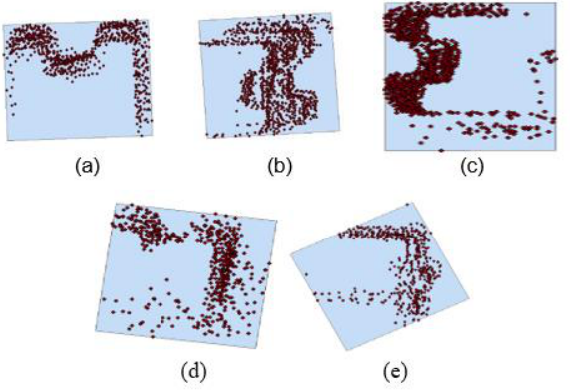
Figure 9 . Rectangle Fitting using ArcMap.